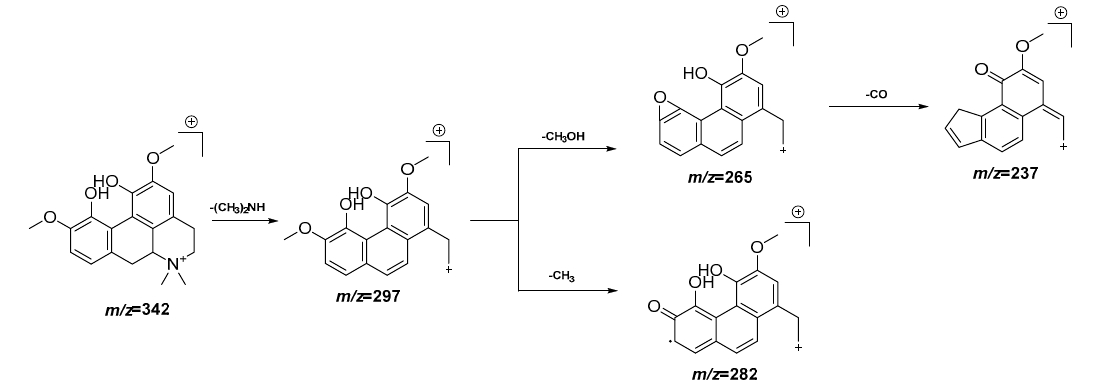
Figure 3. Peak 4, tentative identification of magnoflorine in the EAF fraction of Croton linearis Jacq. leaves. Hypothetical fragmentation pattern adapted from Jiao et al. [26].